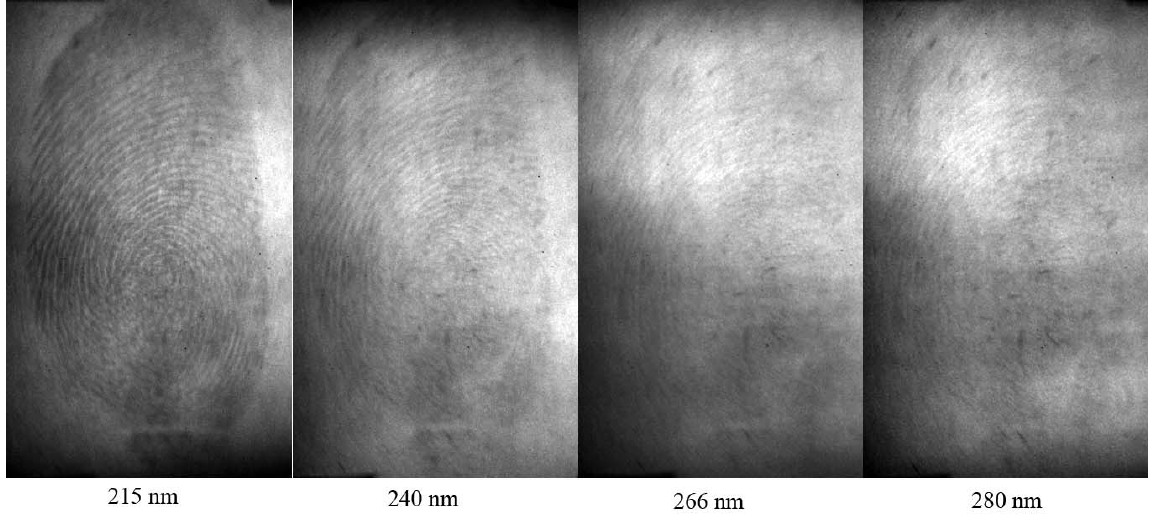
FIGURE 7. Absorption images of latent fingerprints on a HG white paper with various wavelengths.